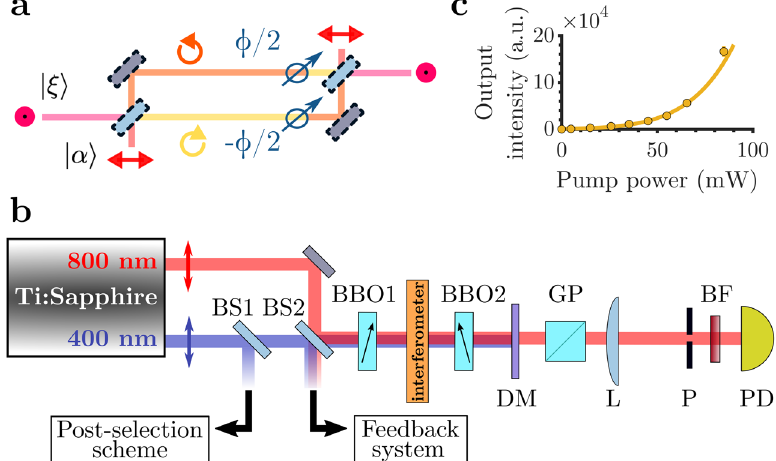
Fig. 2 Squeezing-assisted interferometer with parametric ampli fi cation at the output. a A HWP as a Mach-Zehnder interferometer: left- and right-circularly polarized states play the role of the two arms and linear polarization states, input and output modes. b Vertically polarized squeezed vacuum (SV) is produced in nonlinear crystal BBO1 and the horizontally polarized coherent state is fed through beamsplitter BS2. Vertically polarized output of the interferometer is ampli fi ed in the second crystal BBO2, cleaned from the pump by dichroic mirror DM, selected by Glan polarizer GP, and fi nally detected with photodetector PD1. Lens L and pinhole P provide spatial fi ltering, while bandpass fi lter BF, spectral fi ltering. Beamsplitters BS1, BS2 tap off parts of the pump and coherent beams to monitor intensity fl uctuations and lock the phase. c The output intensity of unseeded BBO2 versus the pump